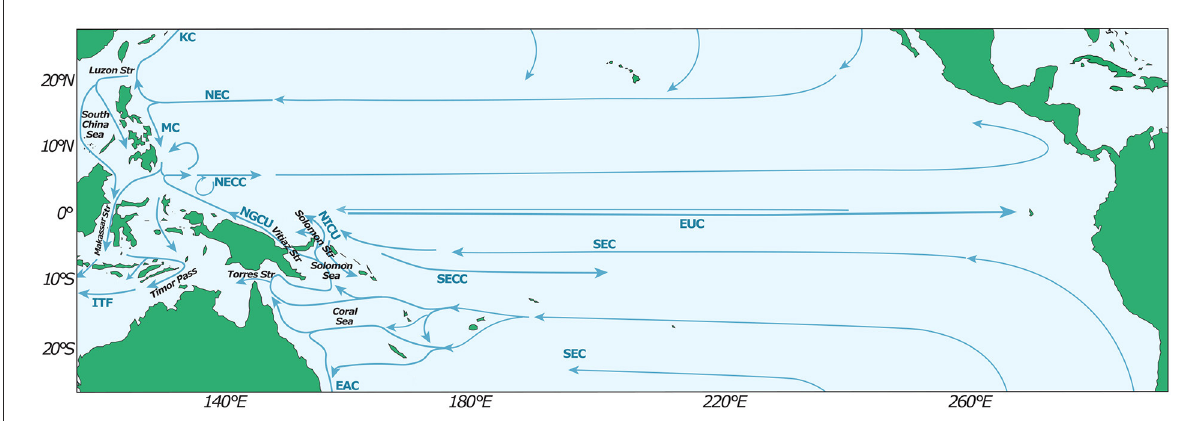
FIGURE1 Schematic of Tropical Pacific Ocean circulation. KC, Kuroshio Current; NEC, North Equatorial Current; MC, Mindanao Current; NECC, North Equatorial Counter Current; EUC, Equatorial Undercurrent; NGCU, New Guinea Coastal Undercurrent; NICU, New Ireland Coastal Undercurrent; ITF, Indonesian Throughflow; SEC, South Equatorial Current; SECC, South Equatorial Counter Current; EAC, East Australian Current. Figure adapted from Hu et al.